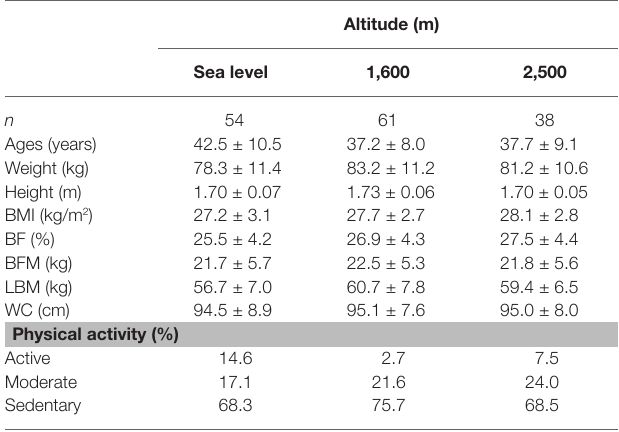
TABLE 2 | Anthropometrical characteristic of population that work at several